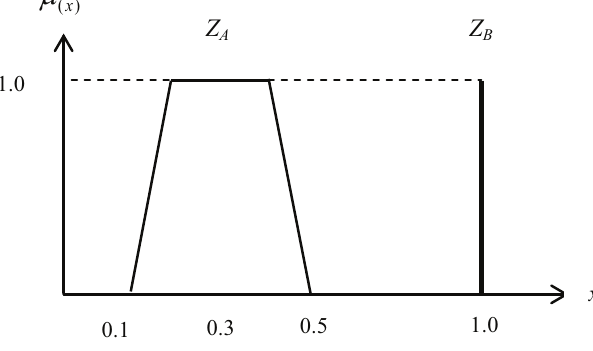
Fig 6.Z – fuzzy numbers Z A and Z B of Case 3.